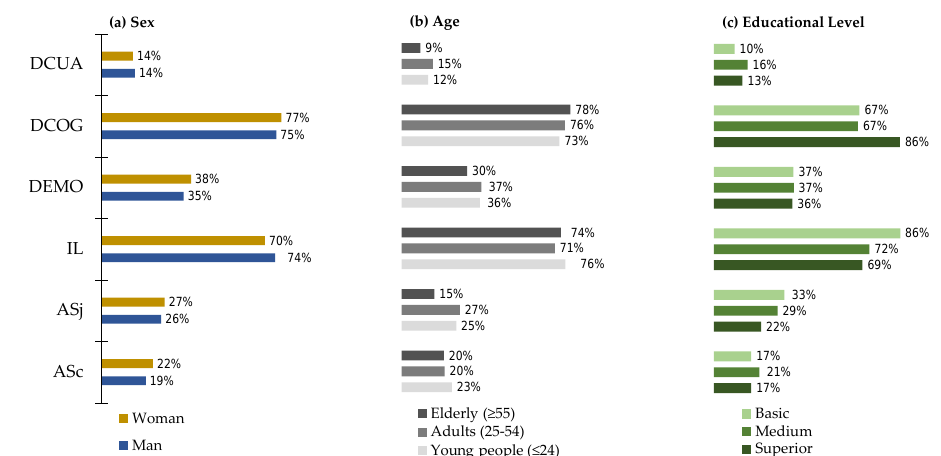
Figure 1. Psychosocial risk factors by socio-demographic characteristics ( n = 1049). ASc = social support from colleagues (% answered No), ASj = social support from bosses (% answered No), IL = job insecurity (% answered Yes), DEMO = emotional demand (% answered Yes / Partly), DCOG = cognitive demand (% answered Yes / Partly), DCUA = quantitative demand (% answered No / Partly).